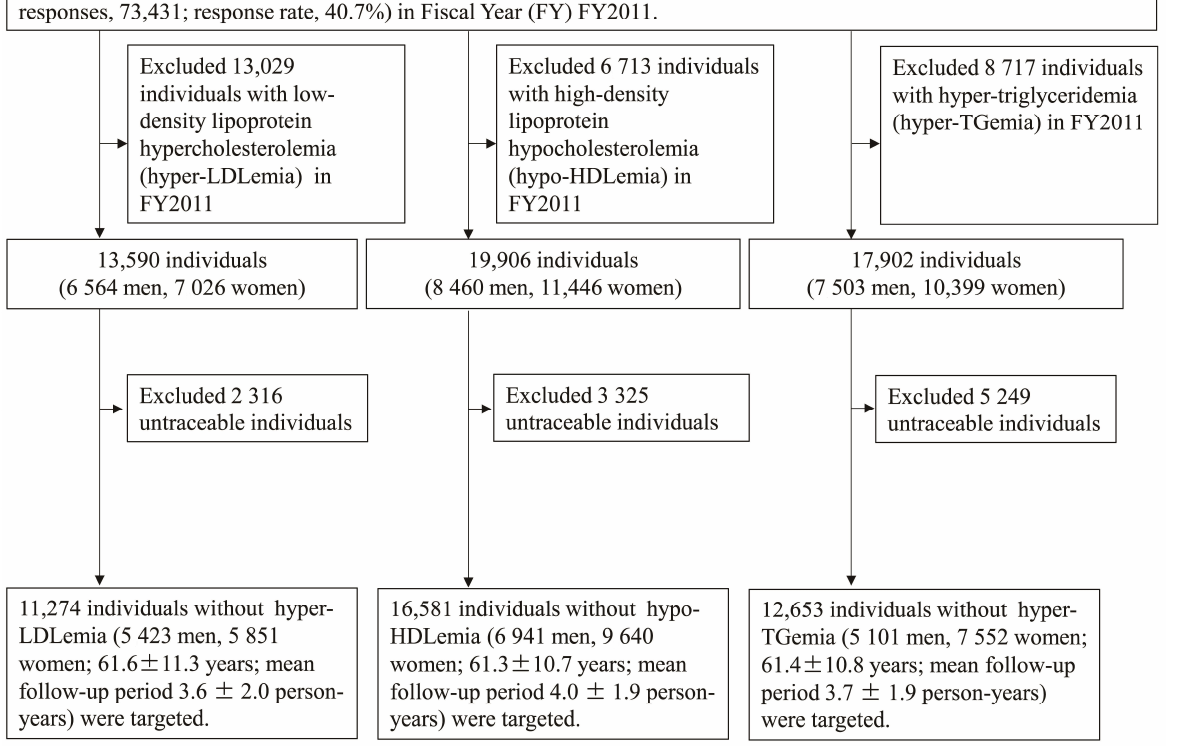
Figure 1. Flow chart of the selection of the research